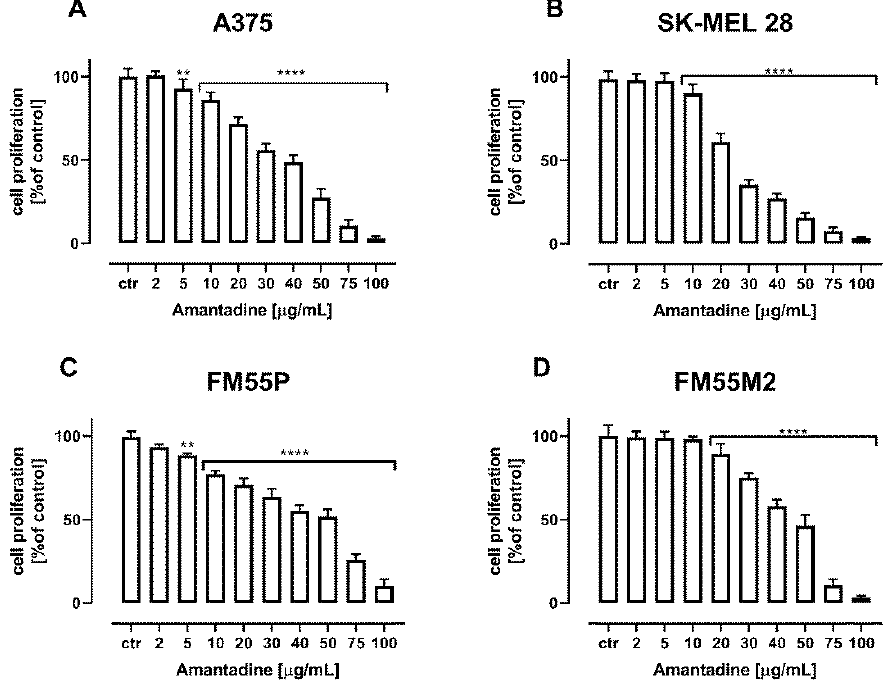
Figure 2. The effect of amantadine on the proliferation of malignant melanoma cell lines ((A375 ( A ), SK-MEL28 ( B ), FM55P ( C ) and FM55M2 ( D )) was measured by BrdU assay after 72 h. Results are presented as mean ± SEM at each concentration (** p < 0.01; **** p < 0.0001).